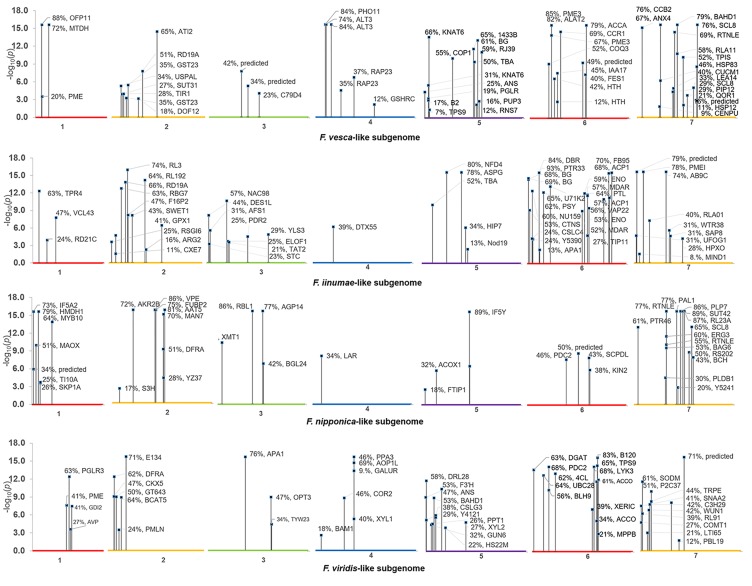
Composite Manhattan plot for octoploid fruit cis-eQTL. The ‘Camarosa’ genome position of the most-correlated marker for each cis-eQTL is shown with single-marker p-value, effect size and BLAST2GO gene annotation.